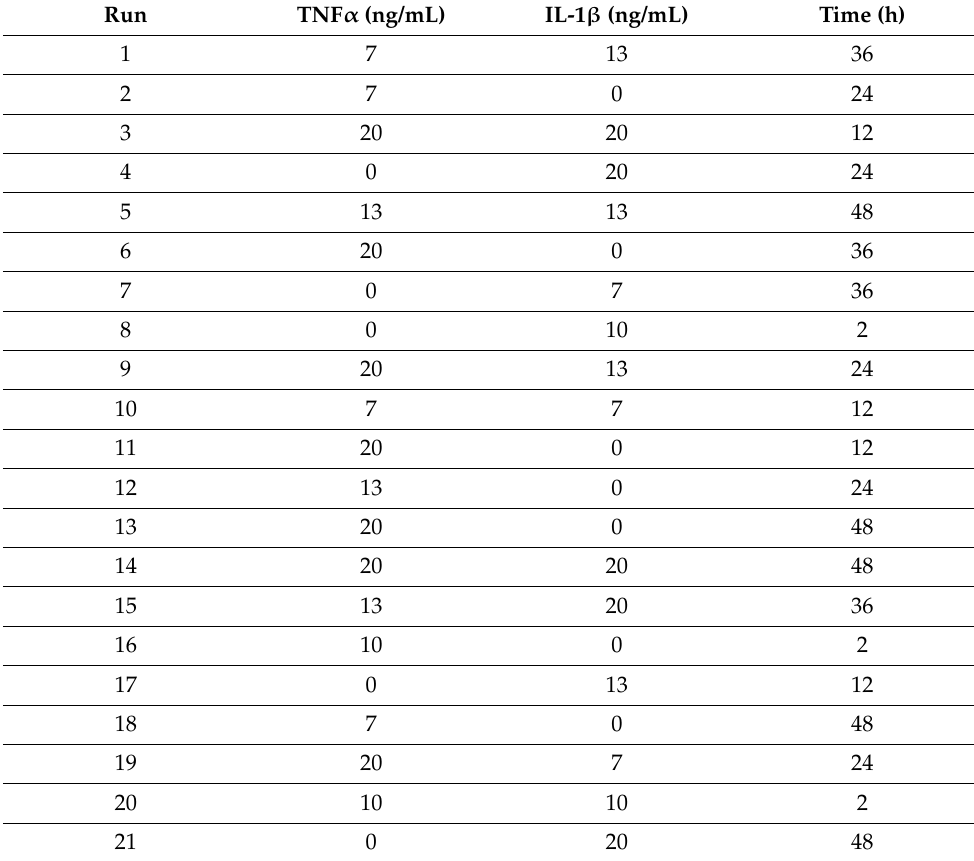
Table 3. Experimental design of the design-of-experiments gene expression